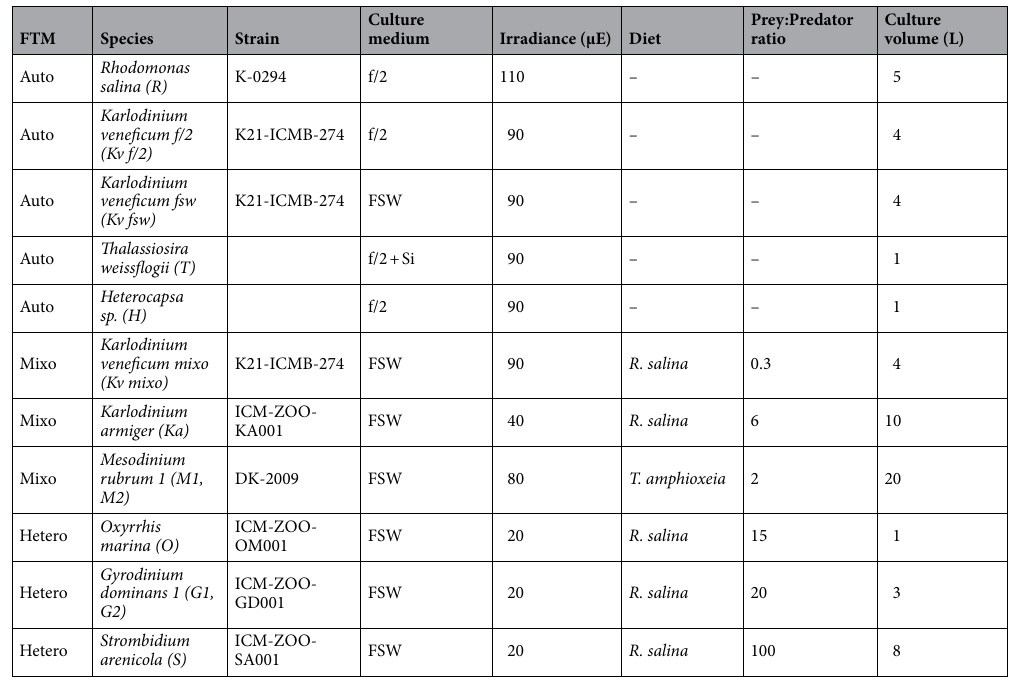
Table 3. Growth conditions of the different prey species. FTM functional trophic mode, Auto autotrophic, Mixo mixotrophic, Hetero heterotrophic. Letters in parenthesis after the species name refer to the abbreviated initials used in graphical representations. FSW plain filtered seawater containing 8.8 µM N (NO 2 − + NO 3 − )